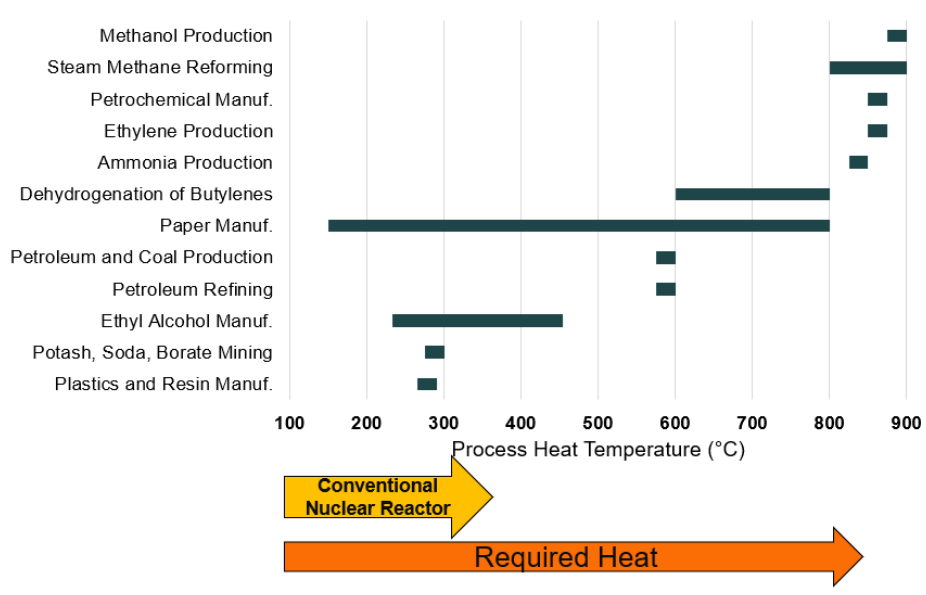
Figure 2. High Temperature Industrial Thermal Processes with Temperature Requirements [4] .